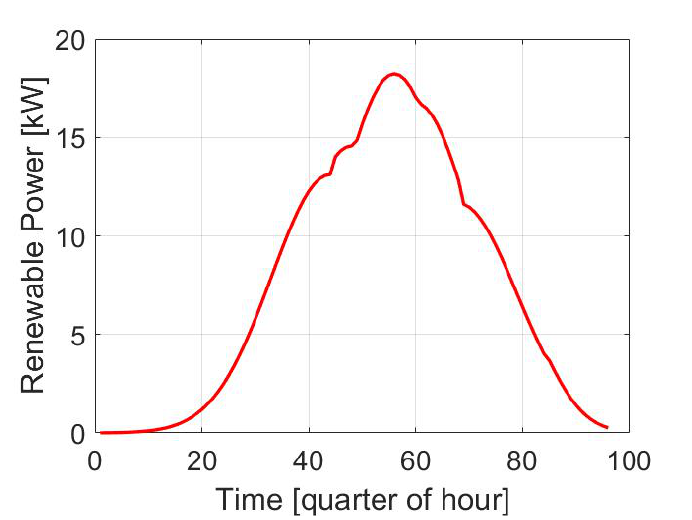
Figure 4. Photovoltaic power plant output. Table 1. List of tasks in the simulation